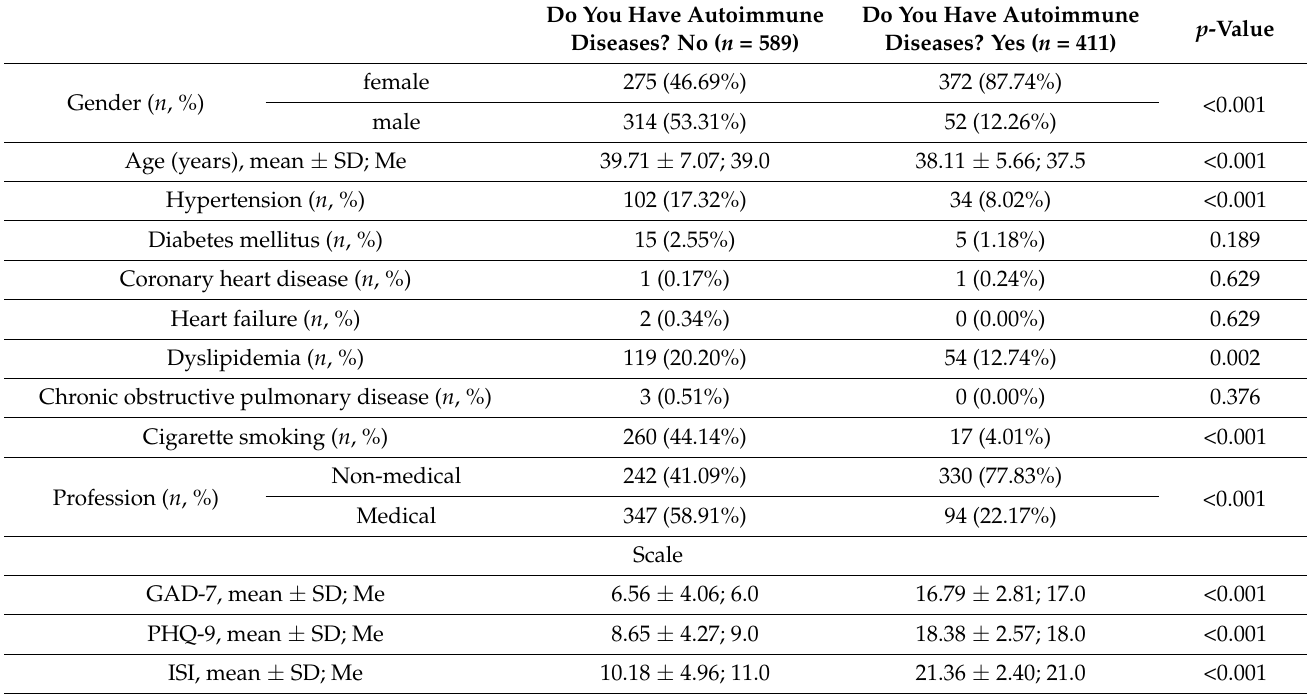
Table 3. Evaluation of selected parameters in relation to the occurrence of autoimmune diseases.